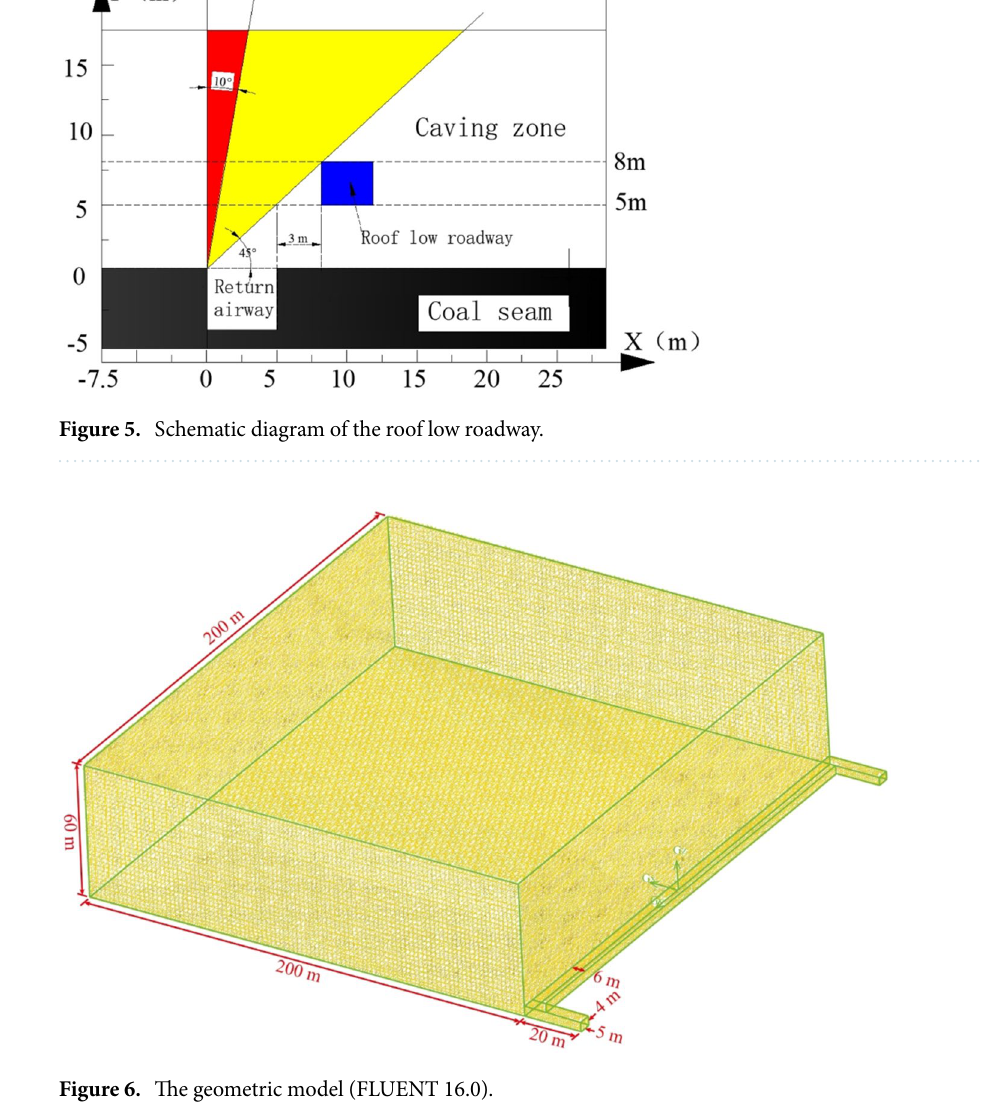
Figure 6. The geometric model (FLUENT